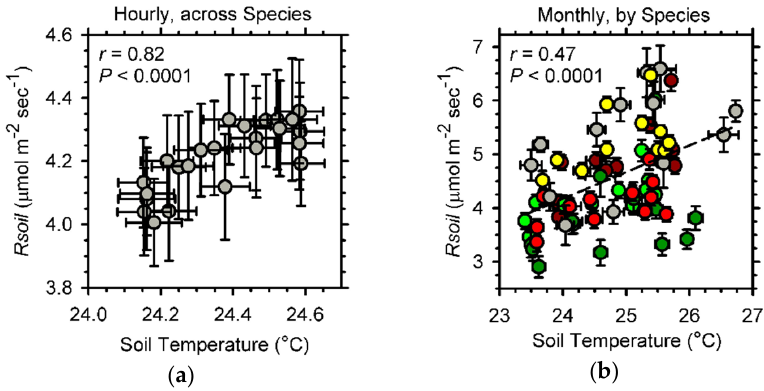
Figure 5. ( a ) Mean hourly soil respiration ( Rsoil ) in relation to mean hourly soil temperature over the course of the diel study ( N = 24, Pearson r = 0.82). ( b ) Mean monthly soil respiration ( Rsoil ) in relation to mean monthly daytime soil temperature for all six species over the course of the across ‐ site survey study ( N = 72, Pearson’s r = 0.50). Symbol colors follow Figure 1; error bars show ±1